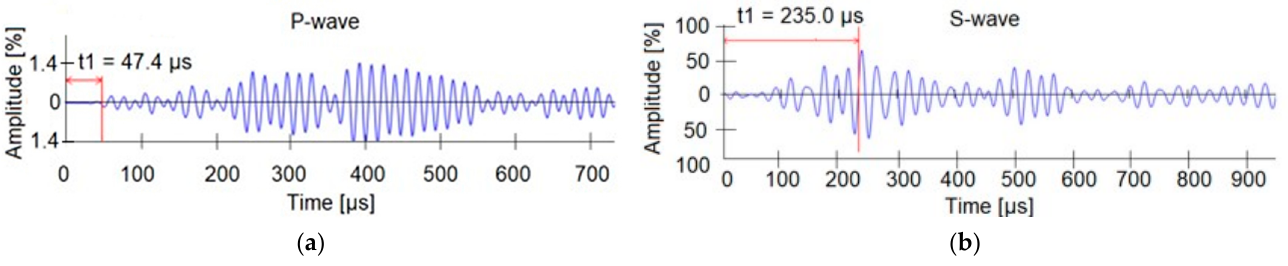
Figure 6. Wave propagation diagram: ( a ) longitudinal wave; ( b ) transverse wave.